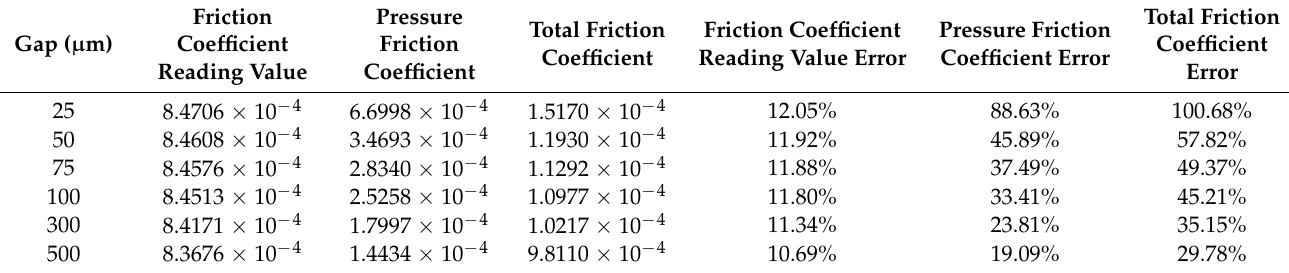
Table 3. Effect of different gaps on total friction coefficient in laminar flow.